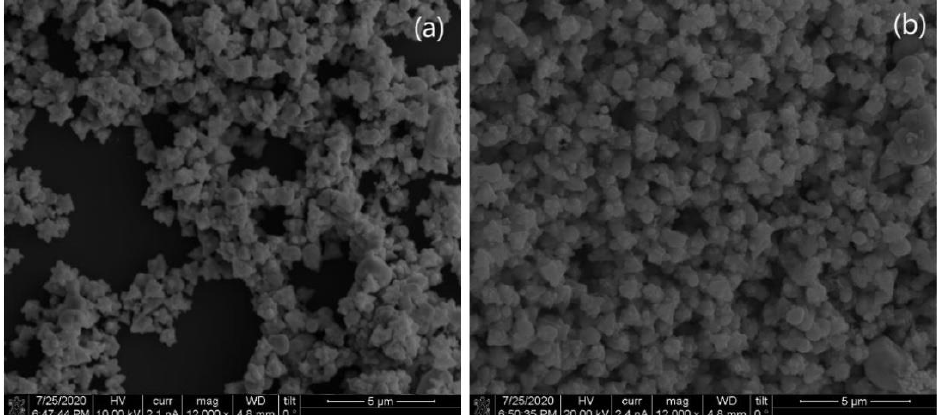
Molecules 2023 , 28 , x FOR PEER REVIEW Figure 13. FE-SEM images of ( a ) CuO NPs and ( b ) NiO [168]. Figure 13. FE-SEM images of ( a ) CuO NPs and ( b ) NiO [168].